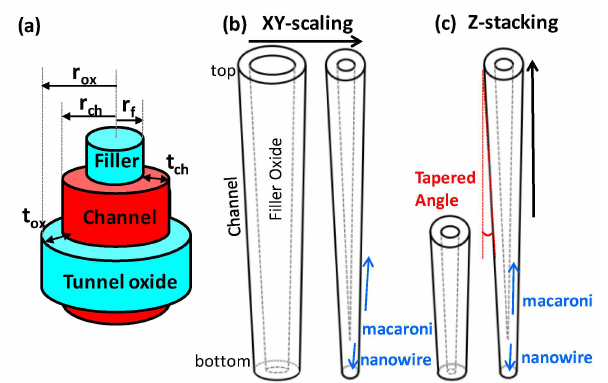
Figure 2. ( a ) Illustrated macaroni structure of 3D NAND. Schematic of showing how the shape of a channel hole in 3D NAND is varied by ( b ) XY-scaling, ( c ) Z-stacking. Note that the cells at/near the bottom would have a nanowire structure because of the tapered structure of the channel